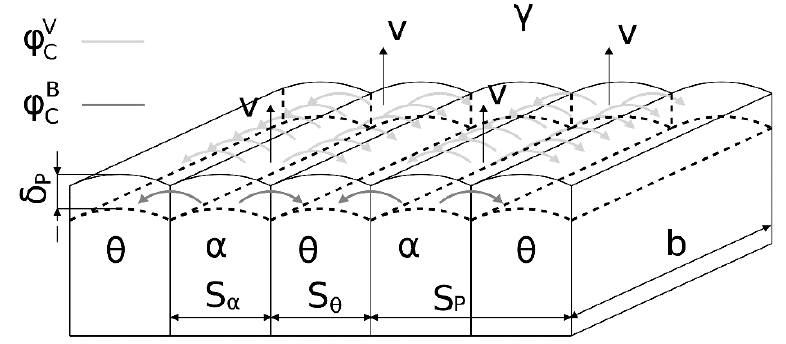
Figure 3. Schematic representation of a growing pearlite colony.